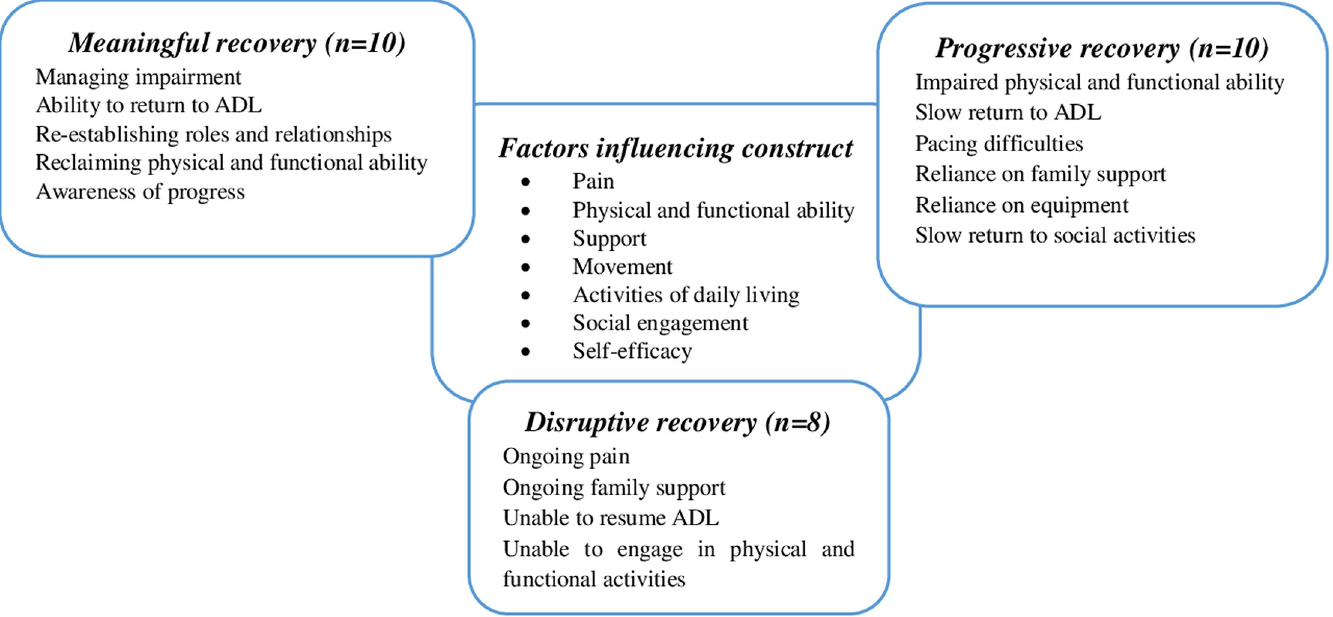
Fig 1. Recovery trajectory following lumber spinal fusion